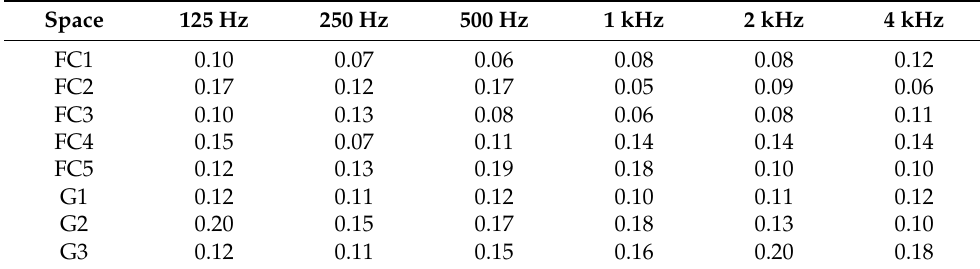
Table 4. Expanded uncertainty of the measured reverberation time T 20 ,